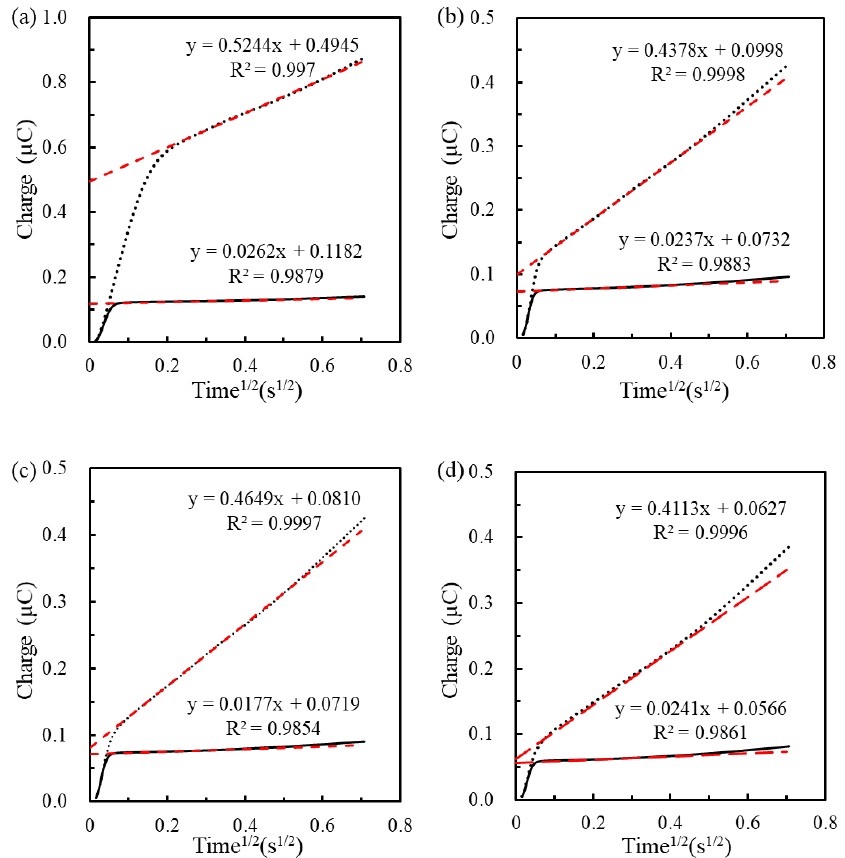
Figure 3. Chronocoulometric curves obtained in 10 mM tris(hydroxymethyl)aminomethane (Tris) buffer (solid line) and 50 μM RuHex-containing 10 mM Tris buffer (dotted line) by applying a step potential from 0.1 V to −0.4 V for 500 ms on the pDNA/MHA(1 mM)/Au electrode ( a ), the pDNA/MHA(0.1 mM)/MCH(1 mM)/Au electrode ( b ), the pDNA/MHA(0.04 mM)/MCH(1 mM)/Au electrode ( c ) and the pDNA/MHA(0.02 mM)/MCH(1 mM)/Au electrode ( d ). The red dash lines show the fits from the raw data.